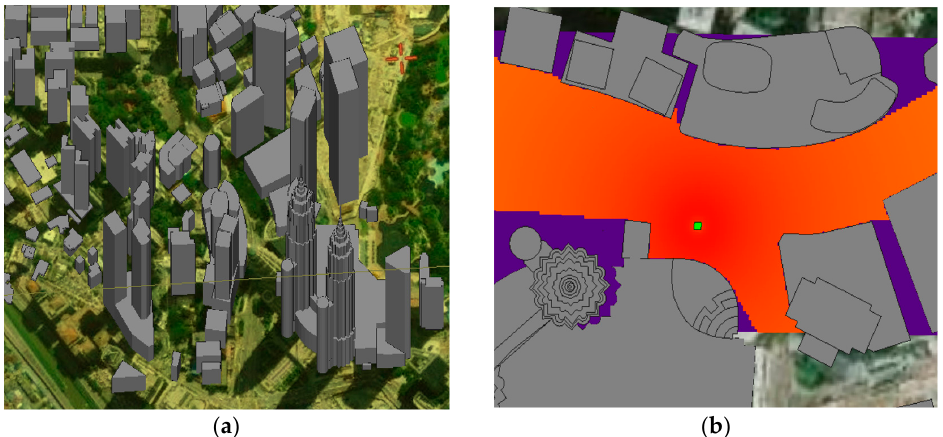
Figure 3. Wireless InSite ray tracer ( a ) 3D Geometric Structure of KLCC and ( b ) UMi visualization with LOS area (blue color) and NLOS area (red color). Table 1. Parameters of the simulation setup.